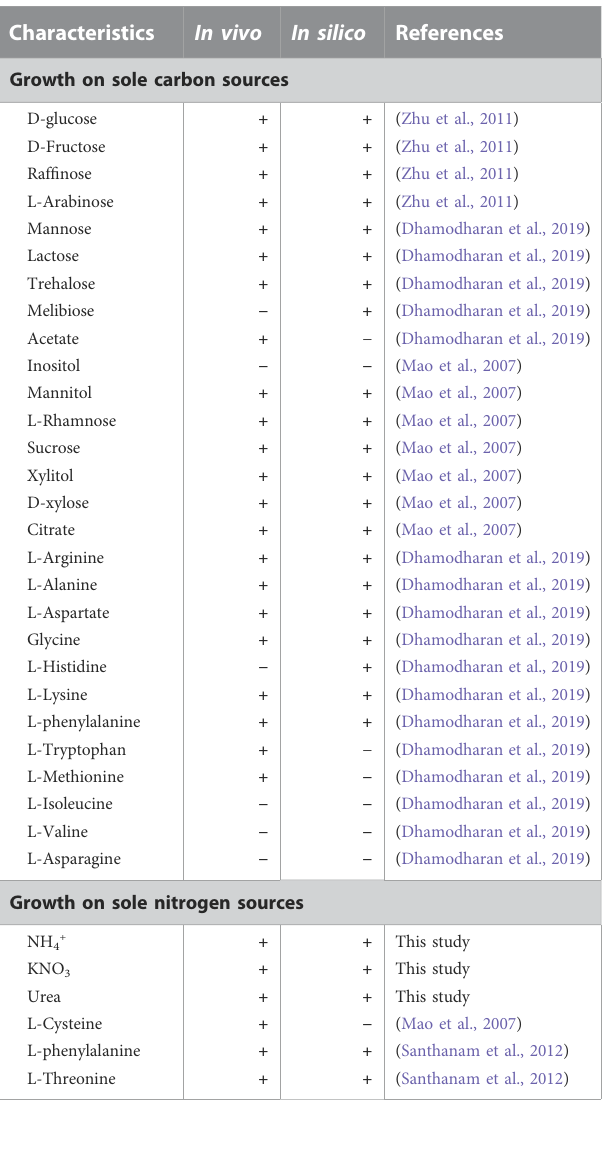
TABLE 2 The utilization of different carbon and nitrogen